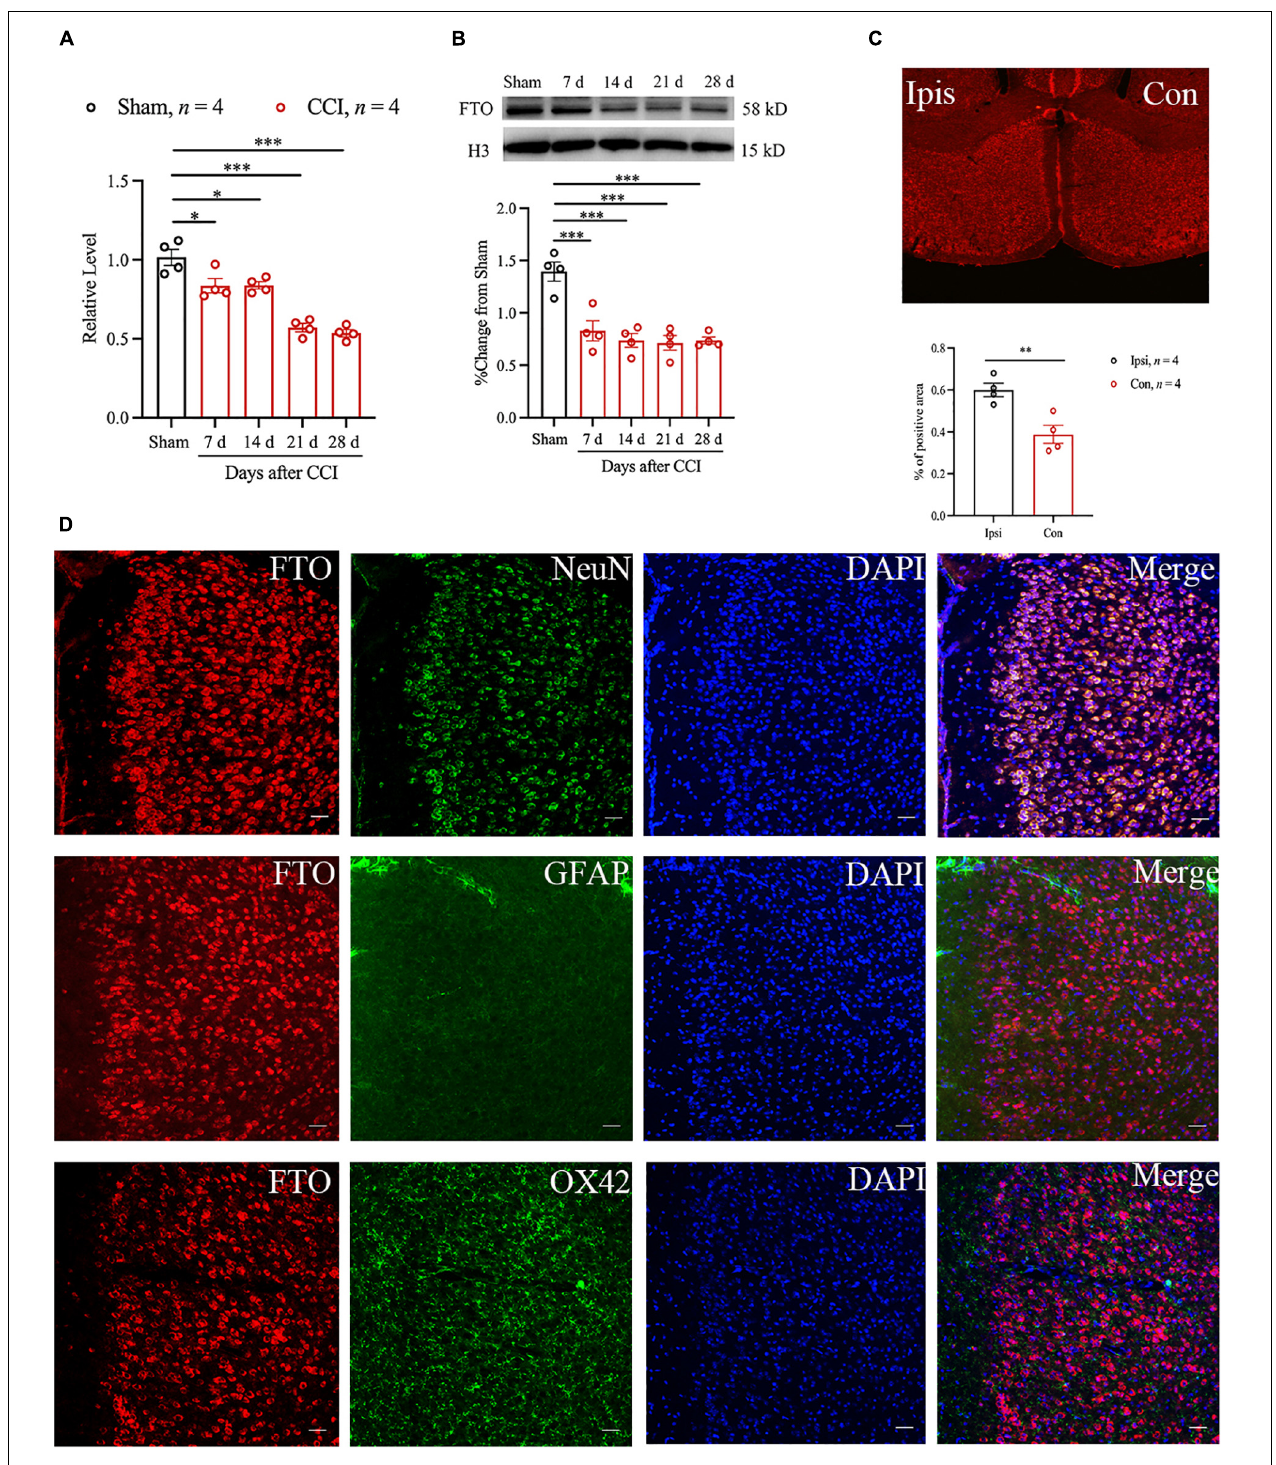
FIGURE 2 | Peripheral nerve injury can reduce the expression of FTO protein and FTO mRNA in mice ACC. (A,B) qRT-PCR and Western blot results showed that the levels of FTO mRNA and protein in ACC of mice decreased significantly 7, 14, 21, and 28 days after CCI ( n = 4, ∗ P < 0.05, ∗∗∗ P < 0.001 vs. Sham). (C) The immunofluorescence results of FTO in ipsilateral (Ipsi) and contralateral (Con) ACC 28 d after CCI ( n = 4, ∗∗ P < 0.01). (D) The IF double staining of FTO (red) and NeuN (a neuronal marker, green), GFAP (an astrocyte marker, green), or ox42 (a microglia marker, green) in contralateral ACC 28 days after CCI. Scale bar, 100 µ m. FTO, fat mass and obesity-related